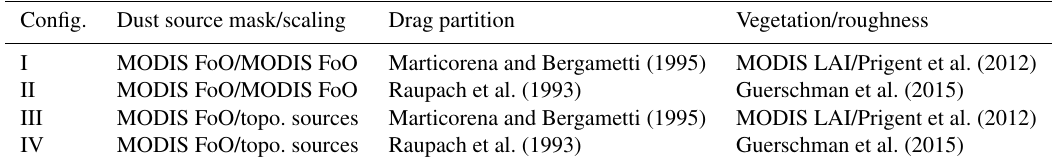
Table 1. Summary of the four model configurations used to create the multi-scheme dust emissions.